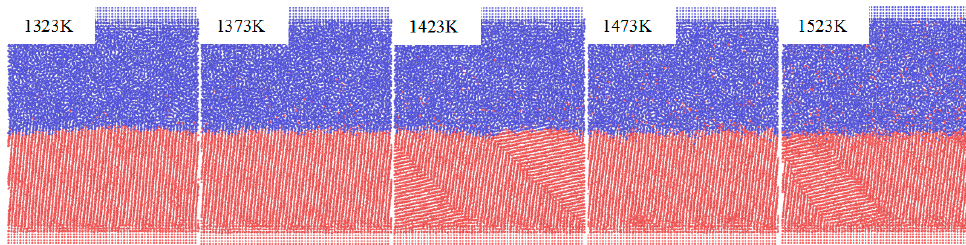
Figure 3. Atomic structure of Fe/Cu interface at different temperatures.